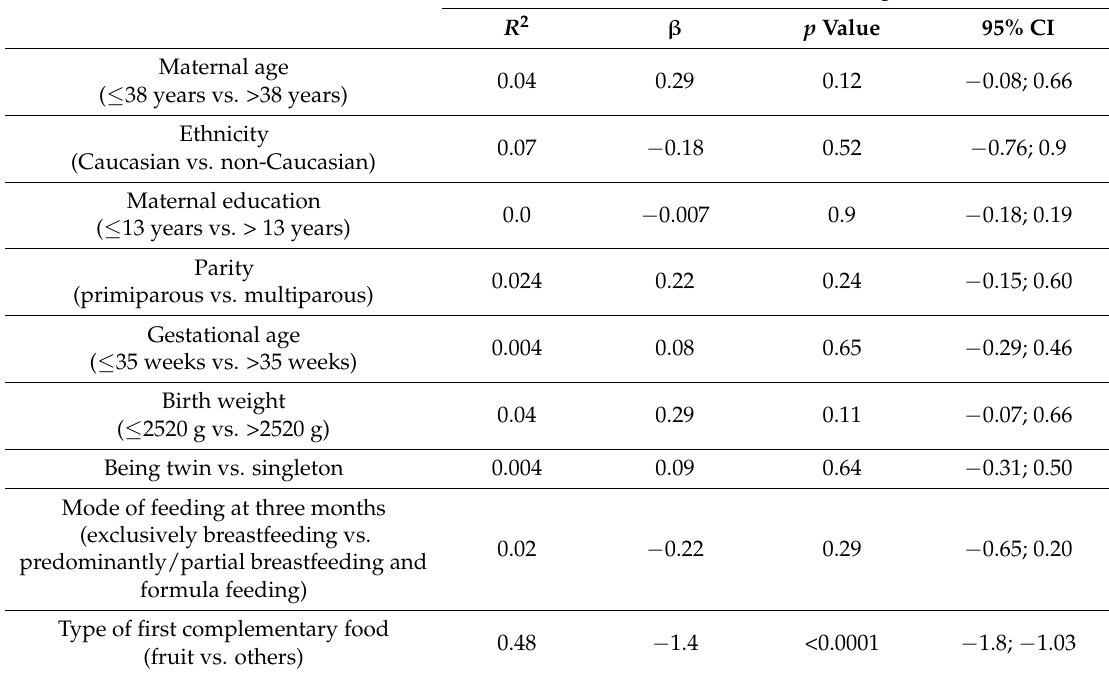
Table 3. Univariate regression analyses of the association between maternal and neonatal characteristics, mode of feeding at three months, type of first complementary food and timing of complementary feeding.